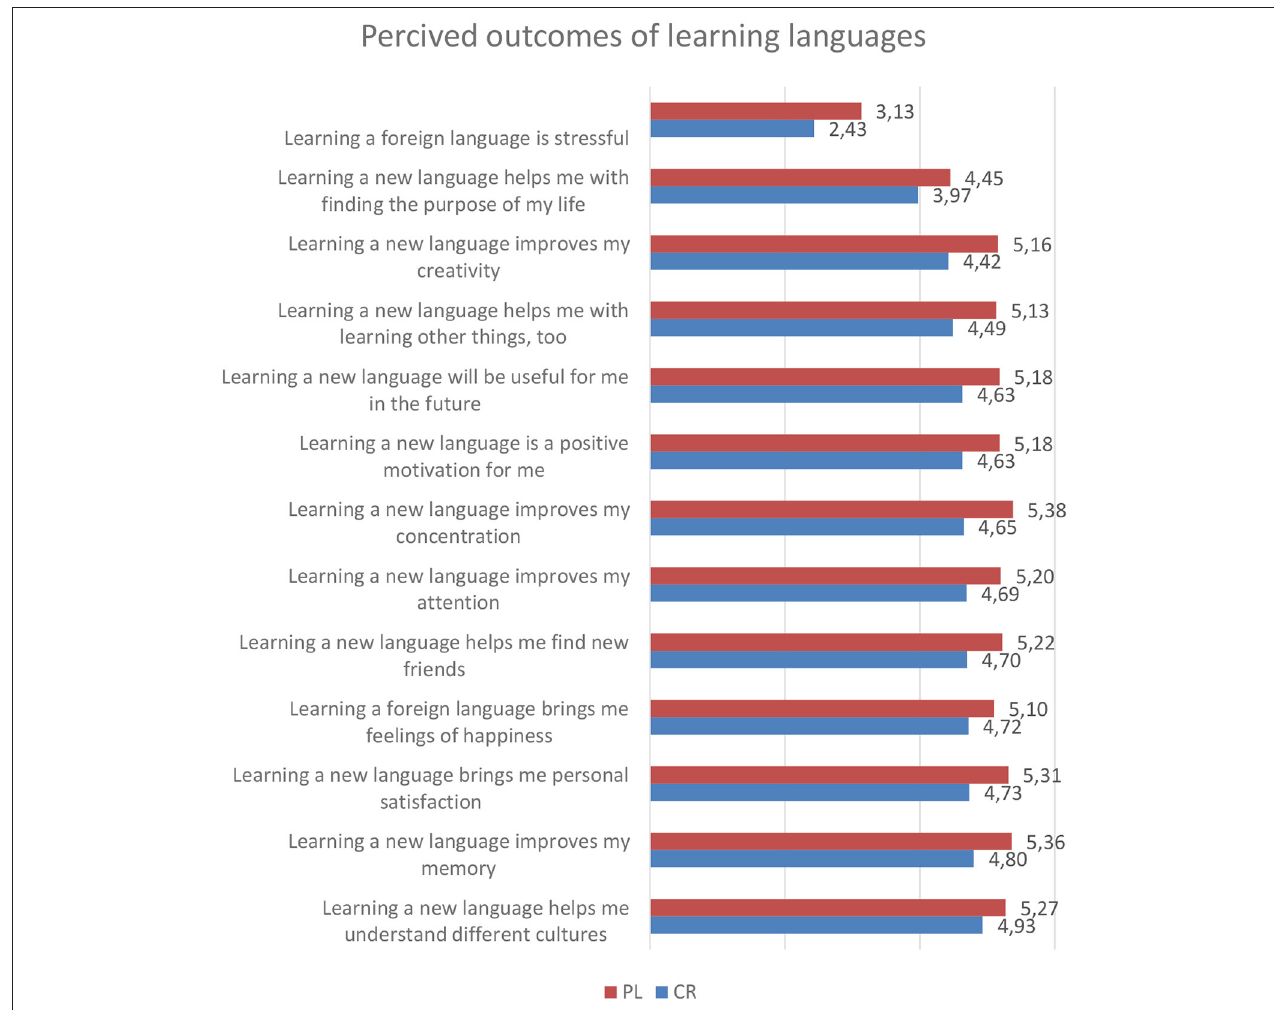
FIGURE 1 | Perceived outcomes of learning languages in Czech and Polish group. The figure consists of the statements with significant differences in means between the groups.